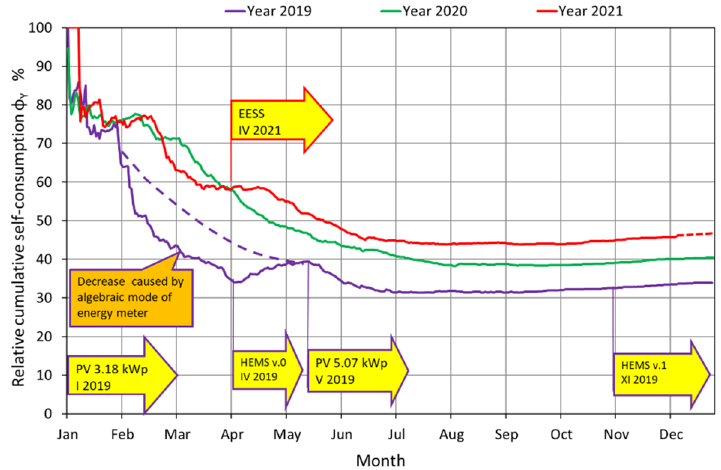
Figure 3. The cumulative SC average in a period of one year.